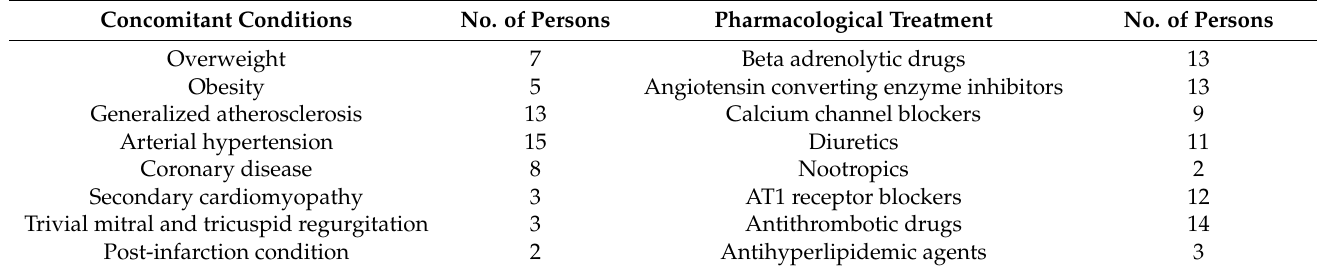
Table 1. Concomitant conditions and pharmacological treatment ( n =